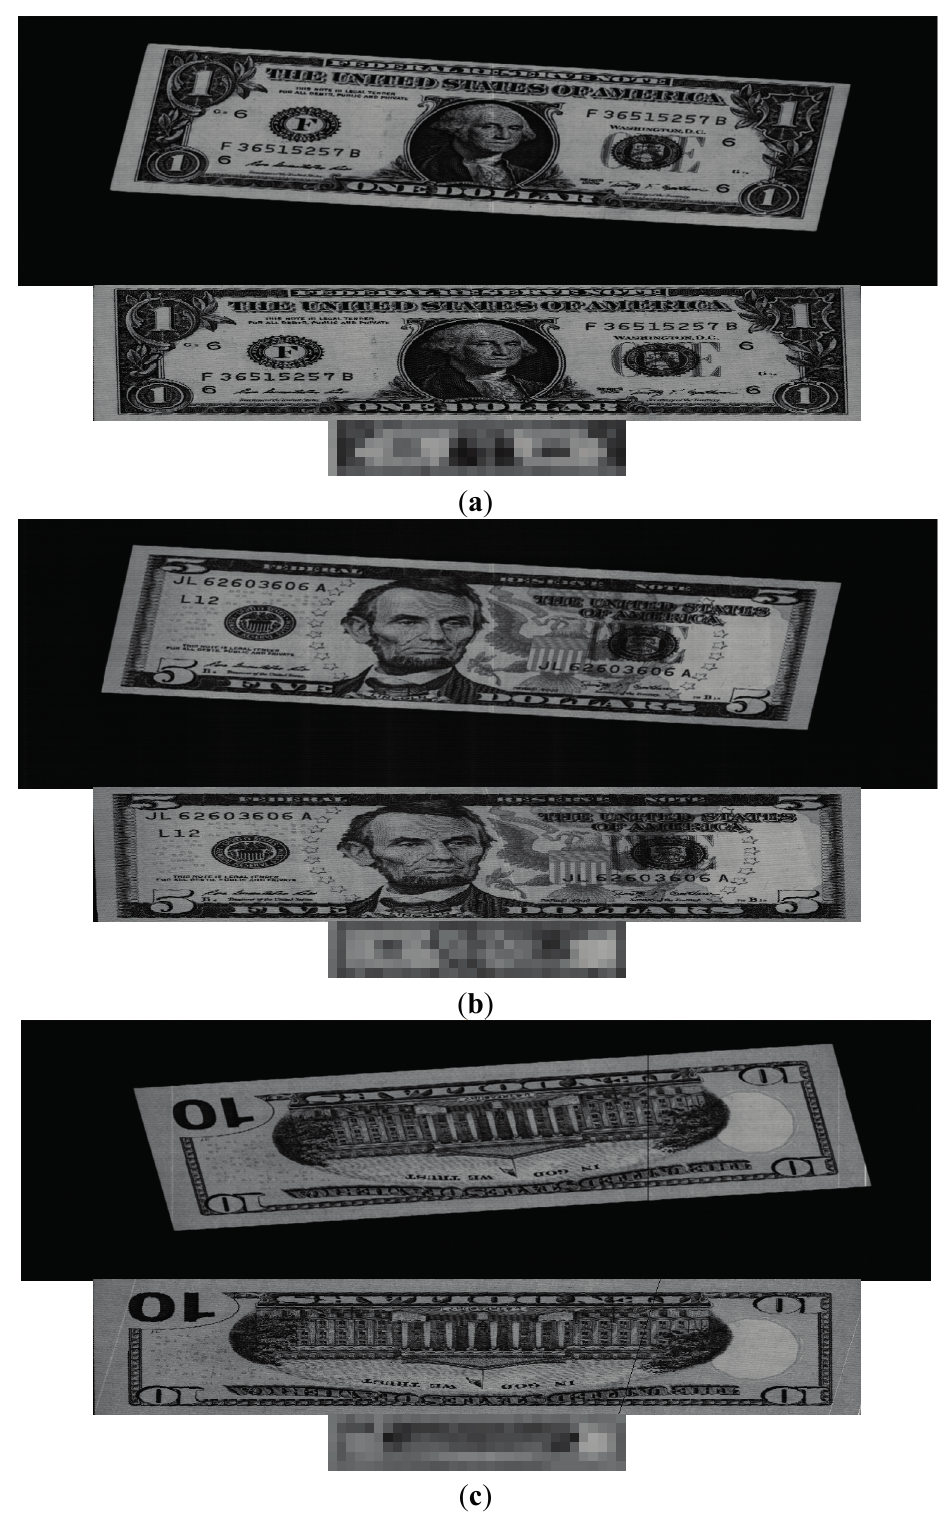
Figure 10. Examples of rotated banknote, the corresponding ROI area, and sub-sampled images. In ( a )–( c ), top, middle, and bottom figures are the original input, ROI area, and sub-sampled images, respectively: ( a ) the 1st example; ( b ) the 2nd example; and ( c ) the 3rd